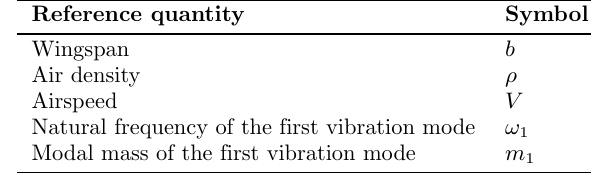
Fig. 1. From the geometry at rest (a) of the reference wing (blue) and the wing under design (red) with a different geometry, a given aeroelastic response can be interpolated from the reference wing to the new one (b). Table 1. Reference quantities used to nondimensionalize the aeroelasticity